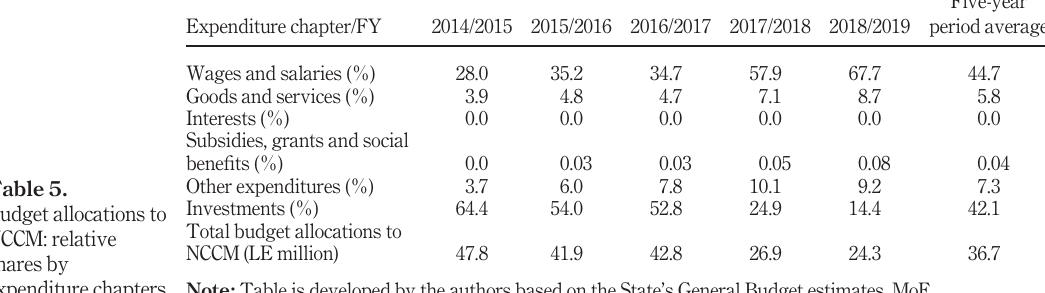
Table 5. Budget allocations to NCCM: relative shares